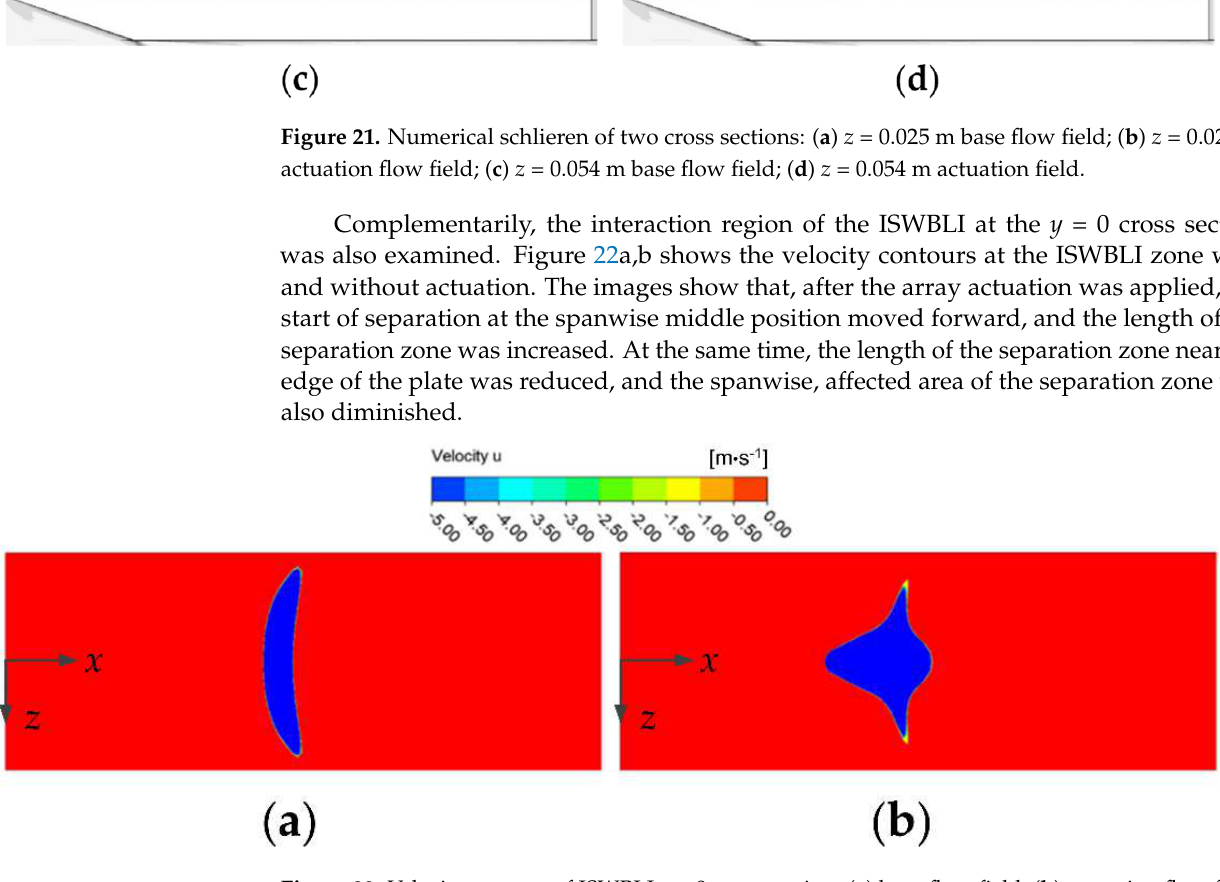
Figure 22. Velocity contour of ISWBLI y = 0 cross section: ( a ) base flow field; ( b ) actuation flow field. Figure 23 shows the curve of the skin friction coefficient at the z = 0 cross section in the x -direction. The red and blue lines represent the base flow field and the actuation flow field, respectively. After the array actuation was applied, the length of the separation zone at the z = 0 cross section increased from 20 mm to 50 mm, which was an increase of 125%. The start of separation in the base flow field was about 120 mm from the plate’s leading edge, and the start of separation in the actuation flow field moved forward, about 100 mm from the plate’s leading edge. These changes show that array actuation is likely to increase the length of the separation zone at the z = 0 cross section, making the start point of separation move